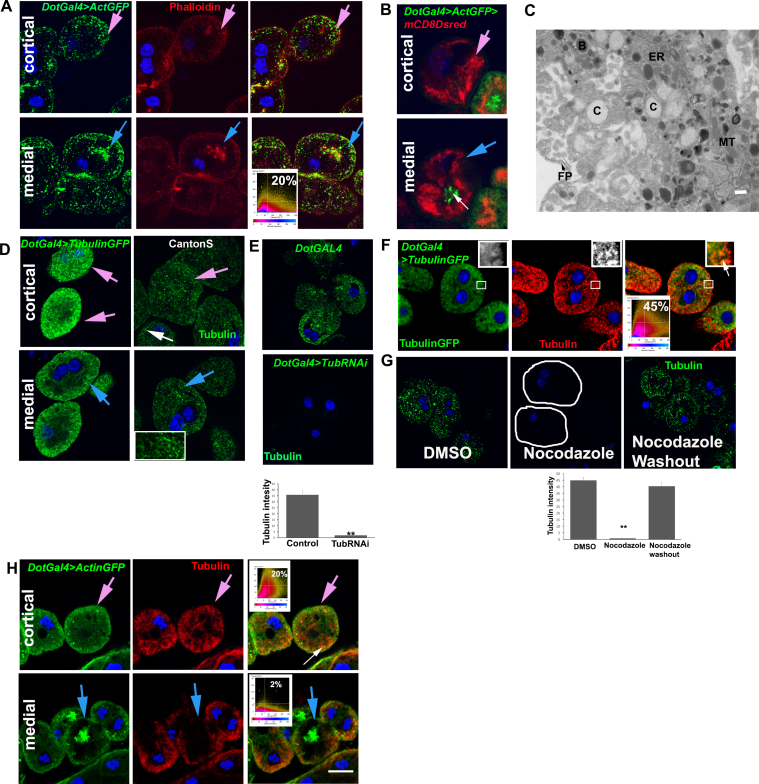
Analysis of nephrocyte actin upon disrupting microtubules and ER. A representative cell at the cortical (pink arrow) or medial (blue arrow) Z slice is indicated. (A) Co-localization of Actin GFP (green) and Phalloidin (red) in nephrocytes. Inset showing the co-localization index. (B) Membrane (red) and actin (green) in nephrocytes expressing DotGAL4>ActinGFP>mCD8 dsred showing that actin cluster is not localized to the cell membrane. (C) Electron micrograph of a wild type nephrocyte showing the subcellular organization. However, the cytoskeletal organization is not discernible at this or at high magnification 19,20. Scale bar: 500 nm. (D) Tubulin staining (green) of nephrocytes in DotGal4>TubulinGFP and CantonS (inset showing the partial punctate appearance of microtubules in nephrocytes). (E) Tubulin (green) staining in control (DotGal4) and DotGal4>UAS Tubulin RNAi nephrocytes. Graphic quantification of the decrease in the Tubulin intensity in the Tubulin knockdown nephrocytes. (F) Co-localization (white arrow) of Tubulin GFP (green) and Tubulin (red) in nephrocytes. Inset showing the co-localization index. (G) Tubulin staining in DMSO, Nocodazole treated and Nocodazole washout conditions in nephrocytes. Graph representing the quantification of Tubulin intensity after the Nocodazole washout compared to the control (DMSO) and Nocodazole treated nephrocytes. (H) ActinGFP (green) and Tubulin (red) partial co-localization (white arrow) at the cortex but not at the actin cluster (Inset: colocalization plots). Data representative of n ≥ 30 from three independent experiments. Scale bars: 10 µm. ER: endoplasmic reticulum, C: C bodies, FP: foot processes, MT: mitochondria.